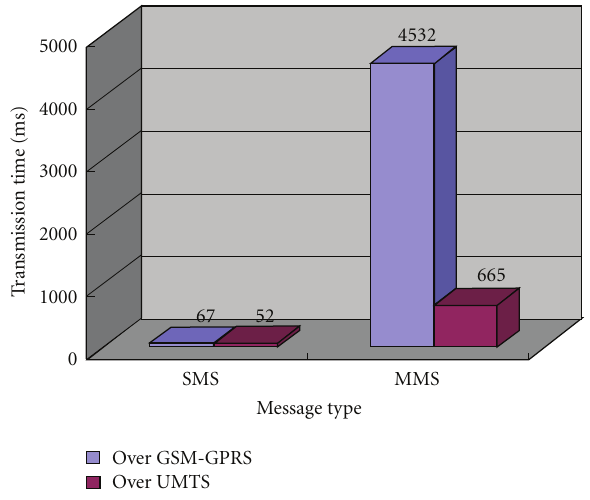
Figure 9: Average transmission time of SMS/MMS messaging over